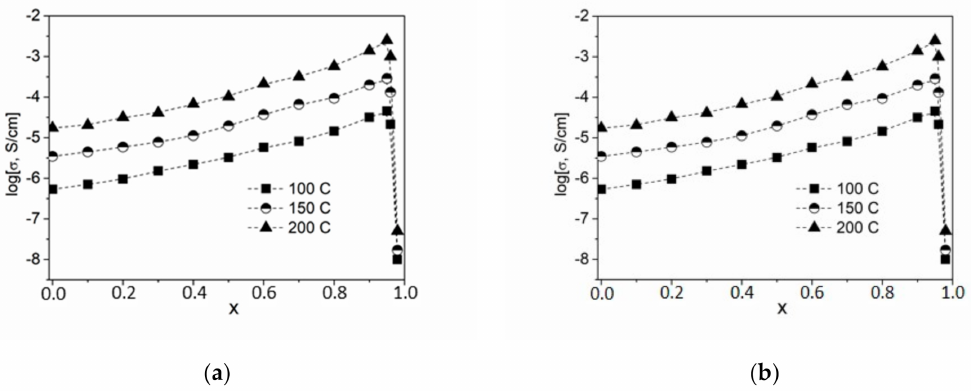
Figure 4. Temperature ( a ) and concentration ( b ) dependences of conductivity for composites (1 − x)CsNO 2 –xND. Points 1, 2, 3, 4, 5 and 6 correspond to the ND concentration of x = 0, 0.3, 0.7, 0.8, 0.9 and 0.95,